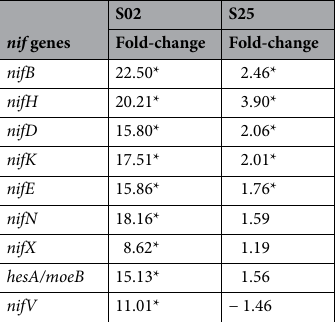
Table 2. Changes in expression levels of the nif operon of Paenibacillus sp. strains S02 and S25 when NH 4 Cl was removed from the media. *Genes that were differentially expressed ( q-value < 0.05 and absolute fold- change ≥ 1.5) when nitrogen was removed from the